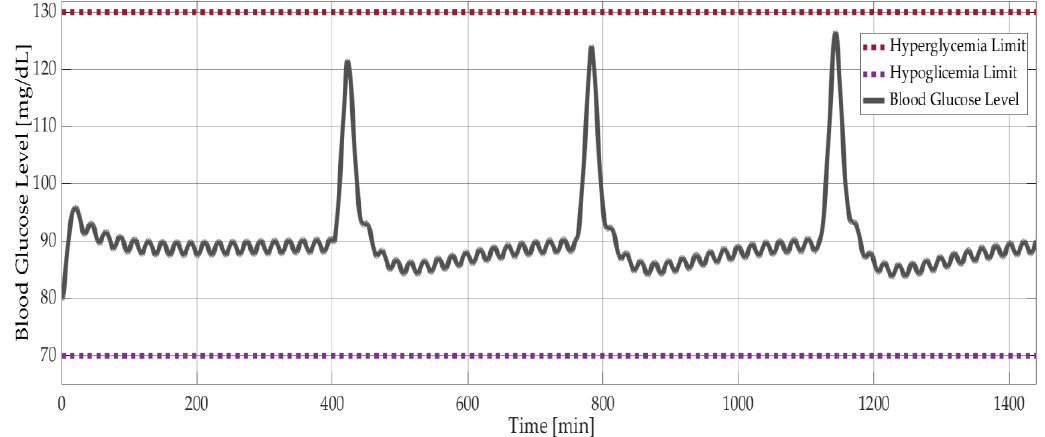
Figure 9. Model-based simulation results: Blood glucose level versus time with PID controlled Sorensen model.